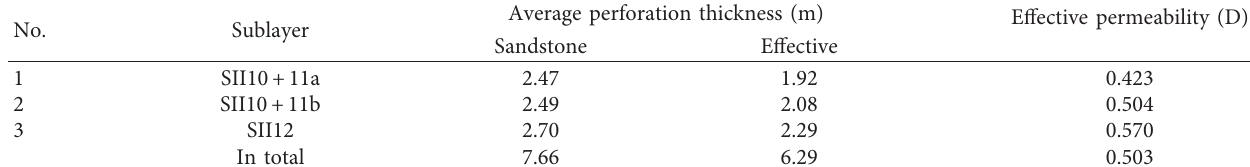
Table 10: B-2-X perforation thickness and permeability distribution [74].